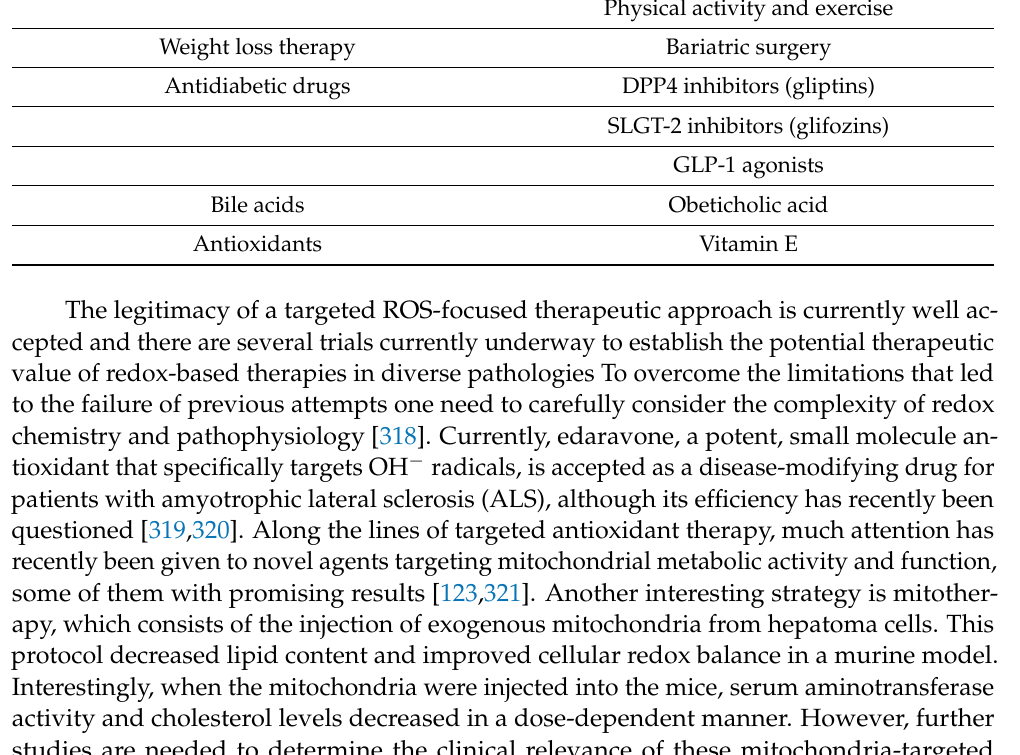
Table 2. Redox-related therapeutic modalities discussed in this review. Category Intervention Lifestyle